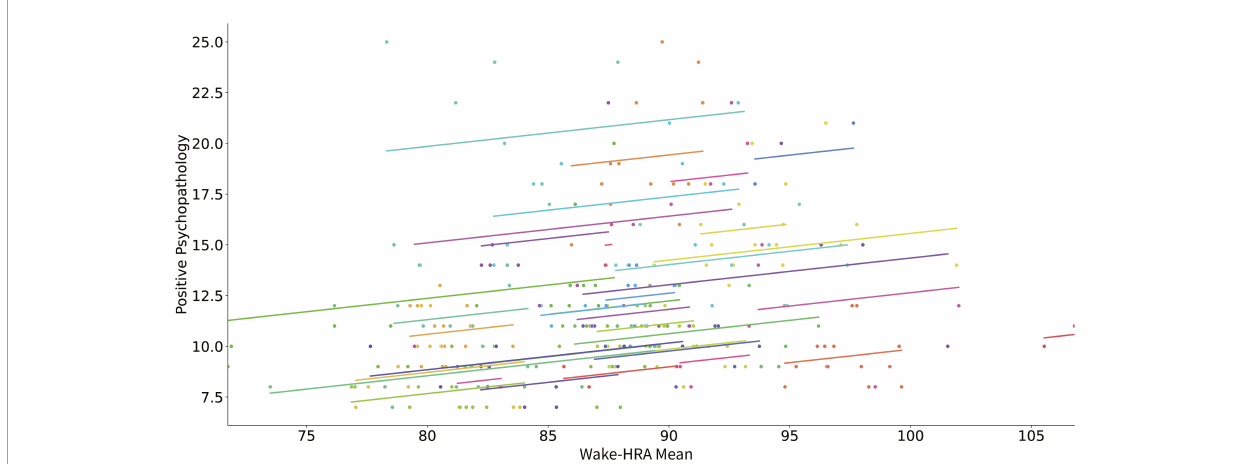
FIGURE1 Scatter plot of the relation of mean HRA during wakefulness and positive psychopathology (positive PANSS score). Each subject’s data as well as the predicted linear model line are presented with a different color.